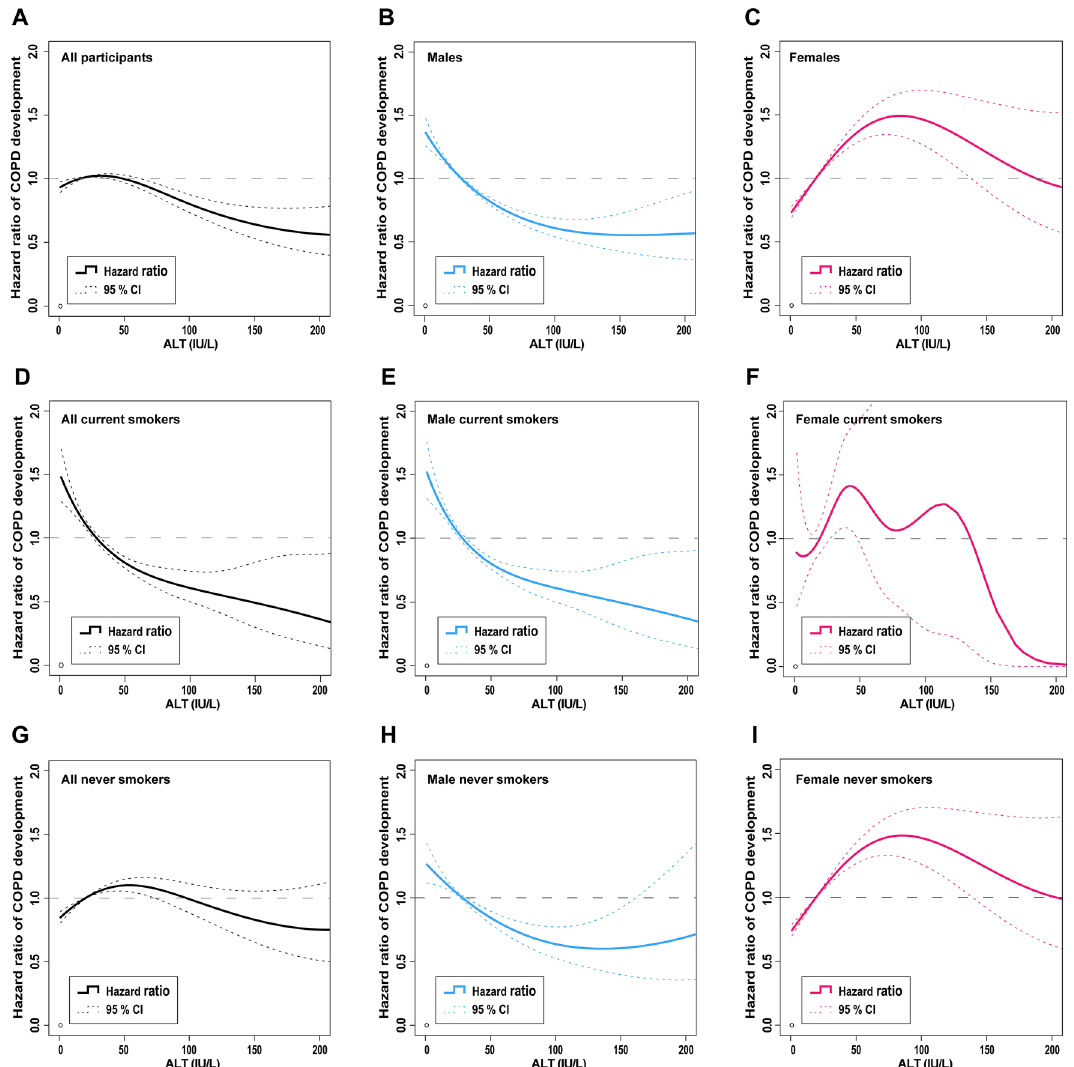
Figure 2. Spline curves of the hazard ratio for COPD development. Spline curves are shown for all participants (A) , males (B) , females (C) , all current smokers (D) , male current smokers (E) , female current smokers (F) , all never smokers (G) , male never smokers (H) , and female never smokers (I) . ALT alanine aminotransferase, CI confidence interval, COPD chronic obstructive pulmonary disease. Adobe Illustrator version Creative Cloud was used to arrange the graphs and to add legends (http:// www. adobe. com/ au/ produ cts/ illus trator.